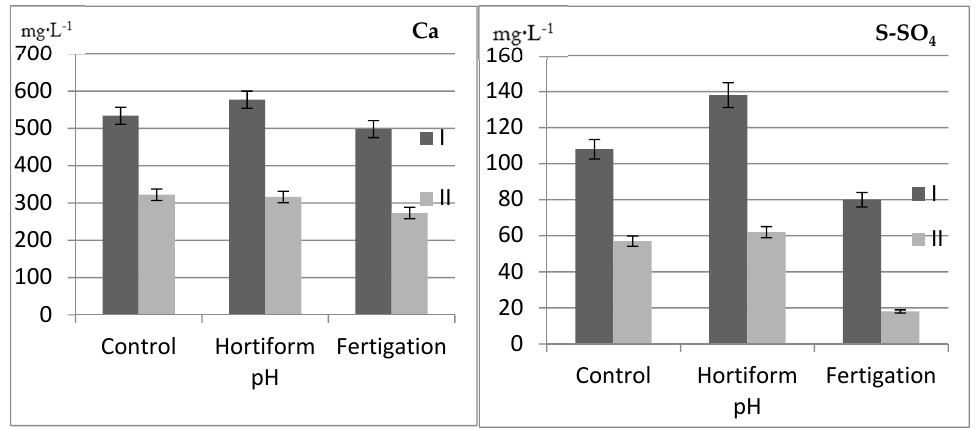
Figure 3. Concentration of N-min., P, K, Ca, Mg and S-SO 4 (mg·L − 1 ) dependent of type of fertilization and analysis term in the azalea substrate. Average from years. I = first decade of August; II = third decade of October.